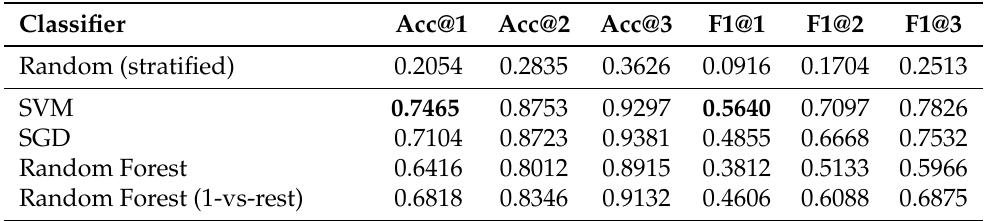
Table 4. Results obtained using the base techniques for economic activity